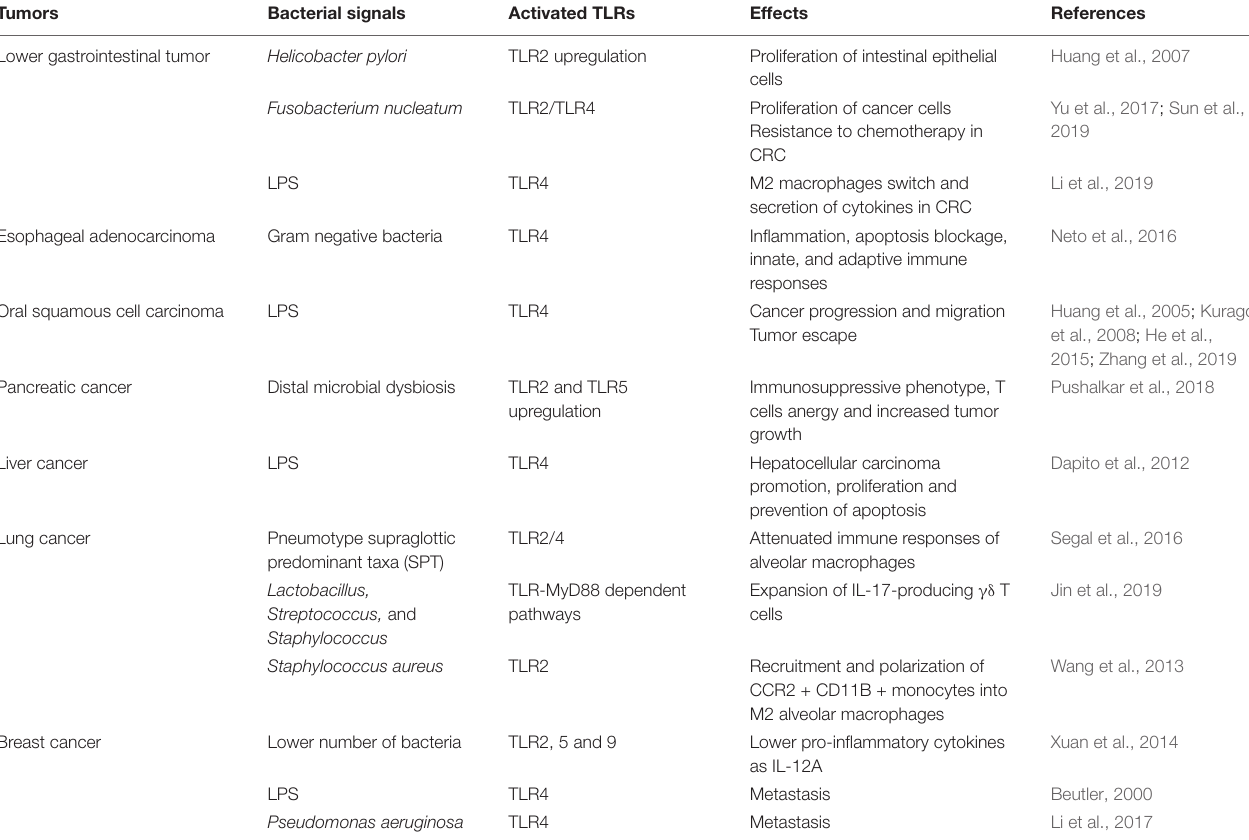
TABLE 3 | Studies revealing the activation of TLRs in response to bacterial presence/perturbation in various